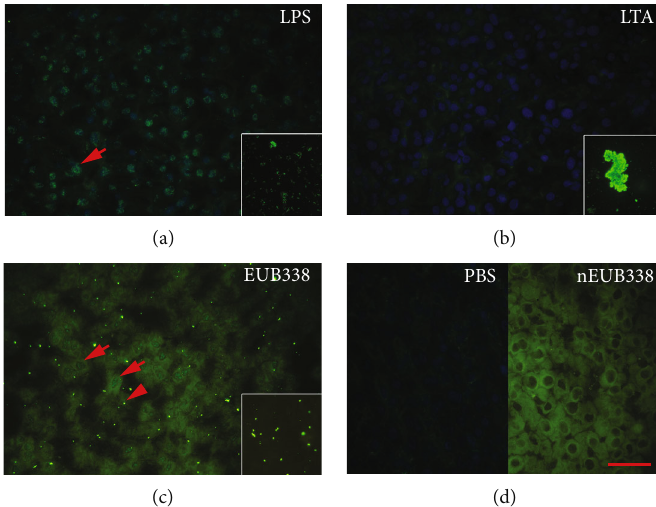
Figure 2: LPS and 16S rRNA were detected in hepatocytes. (a) LPS was detected in the nuclei of hepatocytes (arrow). Insert box: positive control of LPS with E. coli . (b) LTA was not detected in hepatocytes. Insert box: positive control of LTA with Staphylococcus aureus . (c) We detected 16S rRNA with EUB338 in the nuclei of hepatocytes (arrow). Randomly distributed bacterial contamination was the positive control (arrowhead). Insert box: positive control of 16S rRNA with S. aureus . (d) Negative control of IF (PBS) and FISH (nEUB338). Green, FITC labeling; blue, DAPI counterstaining. LPS: lipopolysaccharide; LTA: lipoteichoic acid. Bar = 50 μ m . FITC labeling and DAPI counterstaining images were merged using the NIS-Elements D software. The exposure time was 700 ms.